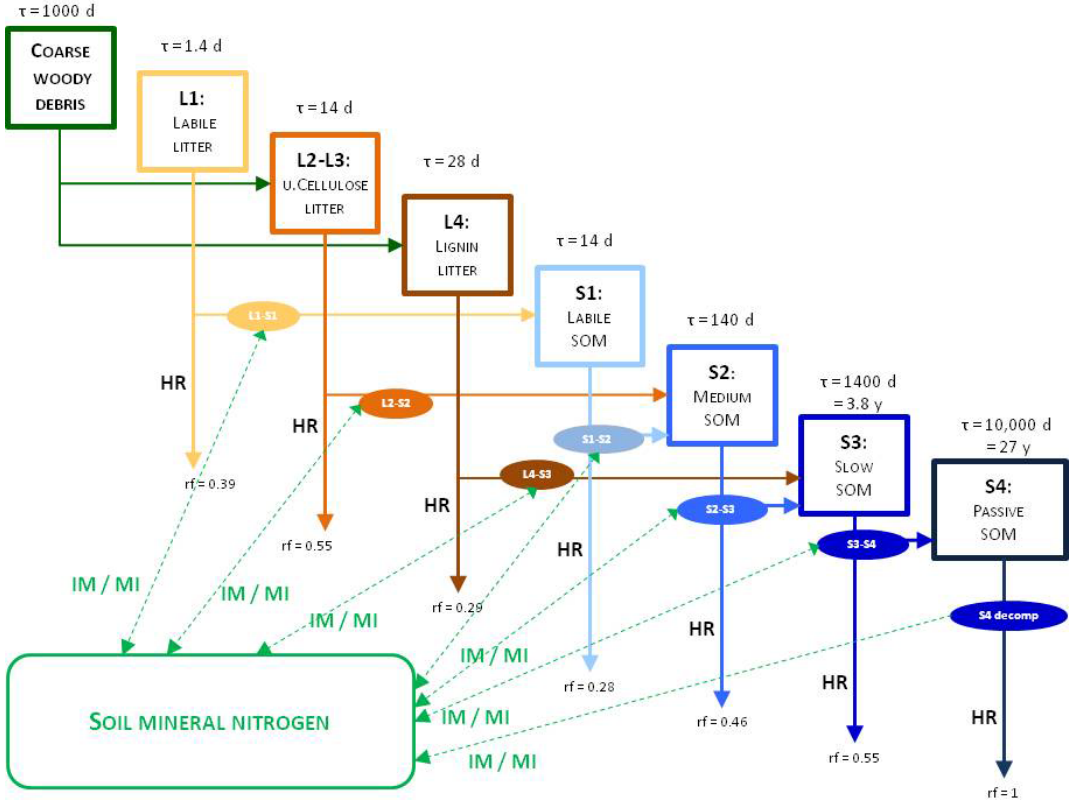
Figure 4. Overview of the converging cascade model of litter and soil organic matter decomposition that is implemented in Biome-BGCMuSo v6.2. The notation rf represents the respiration fraction of the different transformation fluxes, and τ is the residence time (reciprocal of the rate constants, which is the turnover rate). IM/MI: immobilization and mineralization fluxes, HR: heterotrophic respiration. Note that both the respiration fraction and the turnover rate parameters can be adjusted through